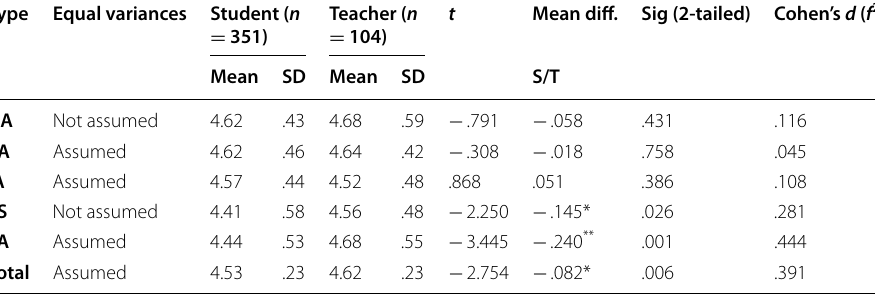
Table 4 Students’ and teachers’ beliefs about classroom assessment